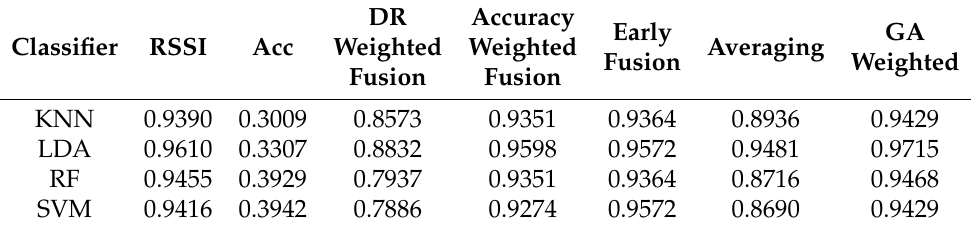
Table 10. Accuracy values for the evaluation protocol 2.